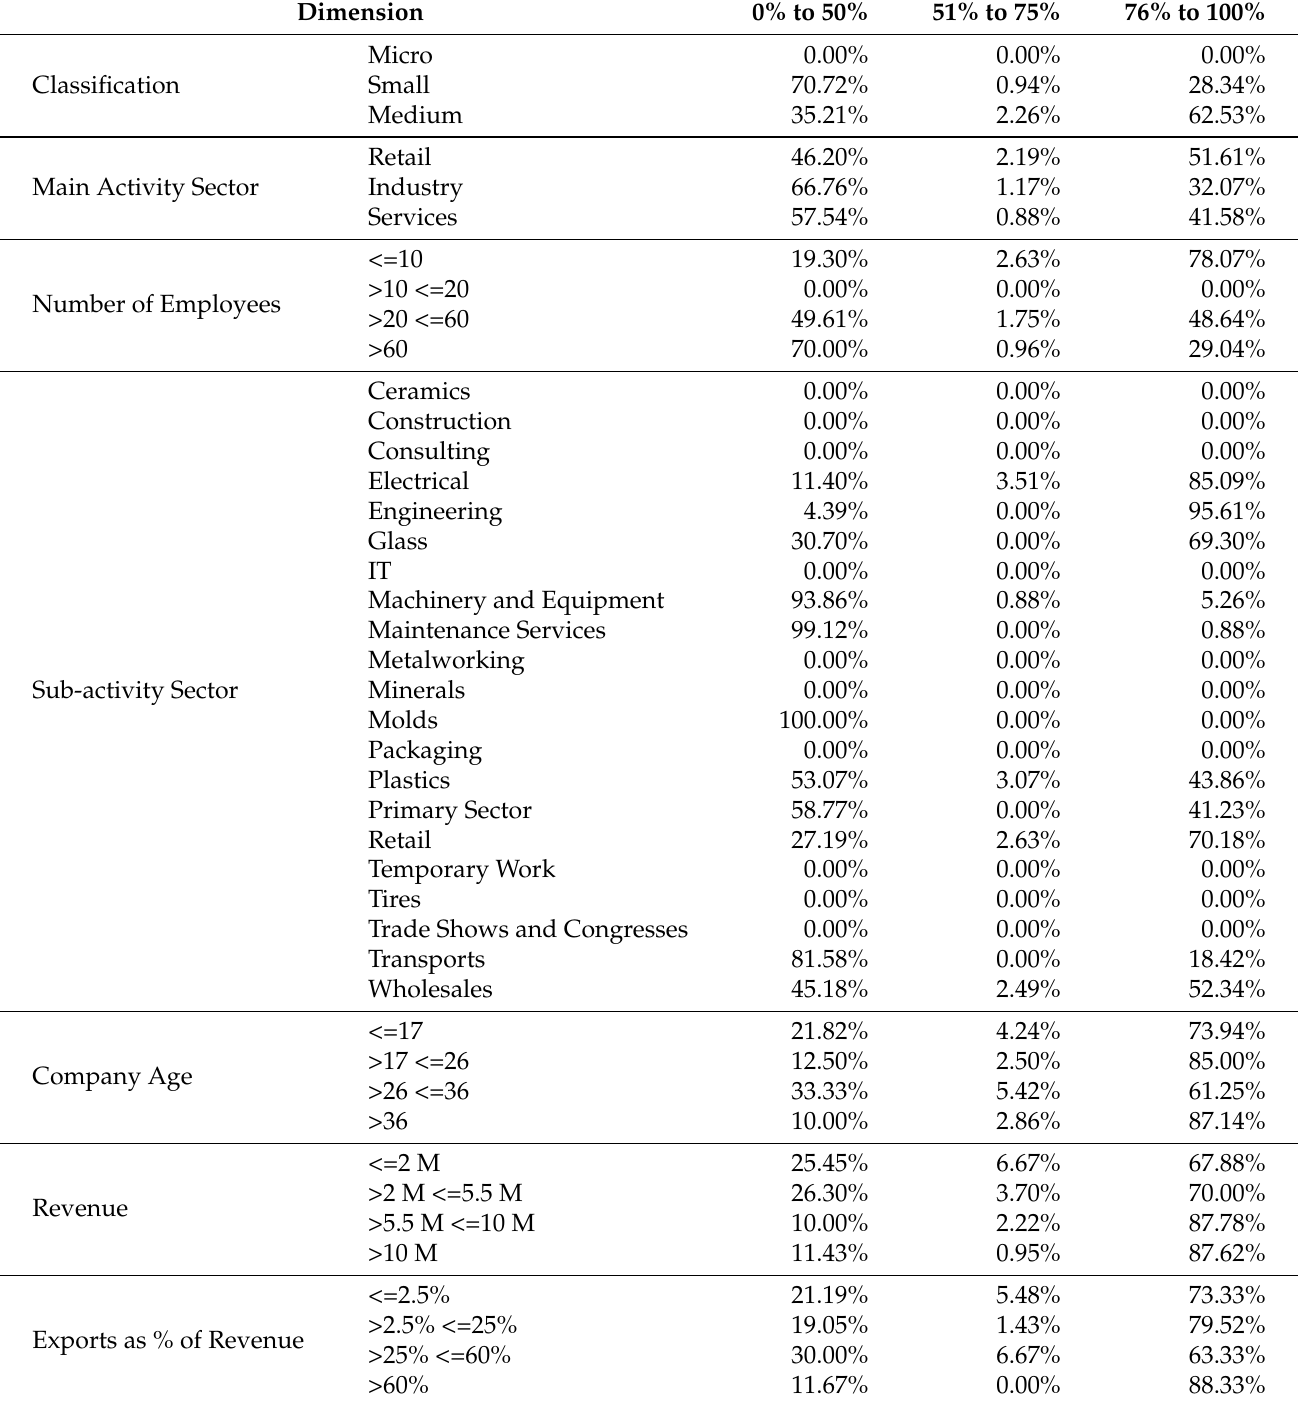
Table 3. Type 2—First Audit—Acceptance percentage intervals of the controls in the predefined